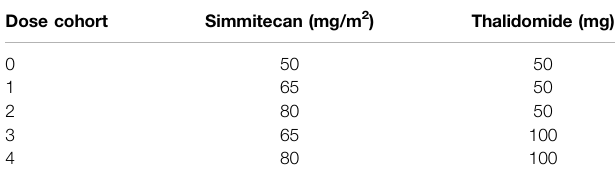
TABLE 1 | Combination of simmitecan and